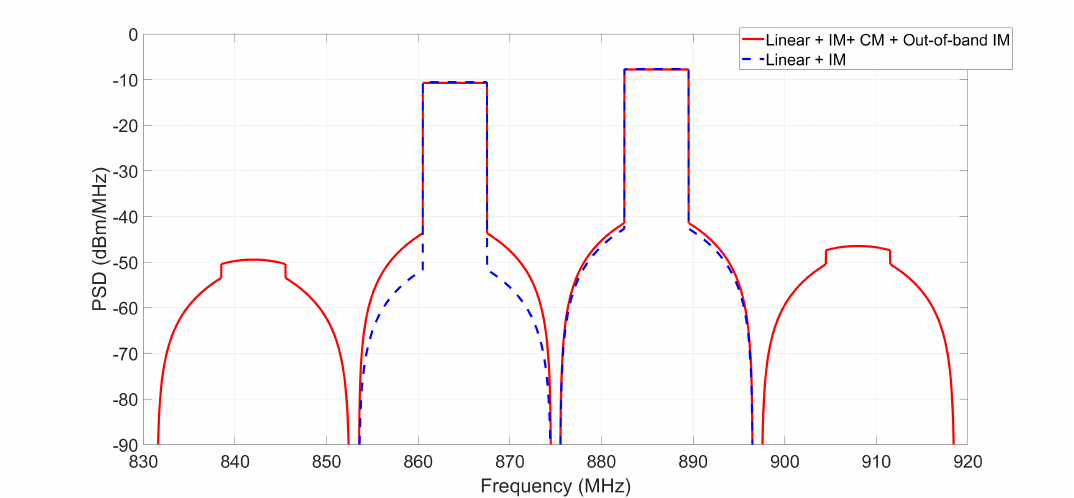
Figure 2. P y ( f ) with and without CM and out-of-band intermodulation.